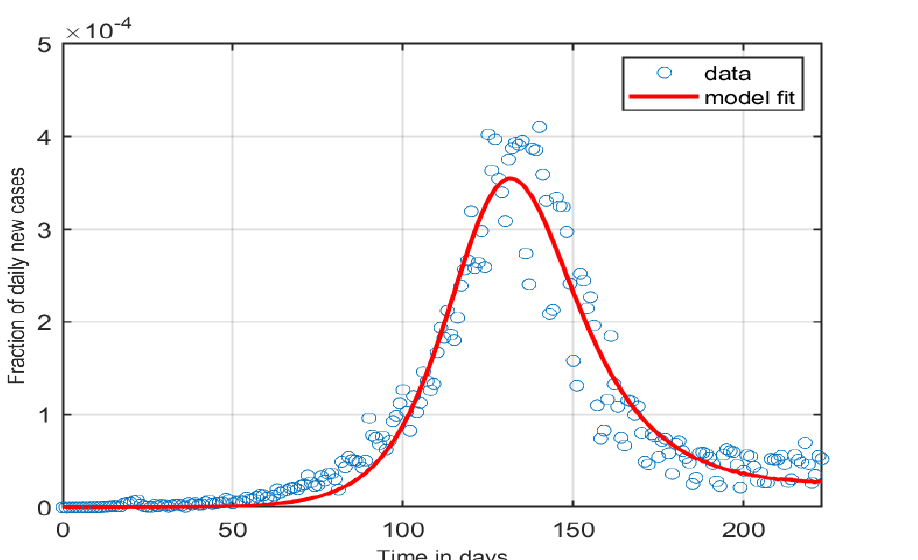
Figure 2. A figure showing the model fitted to the first wave of the epidemic in South Africa for the fol- lowing parameter values: µ = 0.01, β = 2.6060, η = 0.4651, q = 0.9571, κ = 0.3143, σ u = 0.54511, σ d = 0.9649, α 1 = 0.0050, α 2 = 0.0842, δ u = 0.1693, δ d = 0.5033, ν 1 = 0.0957, ν 2 = 0.0100, ρ 0 =